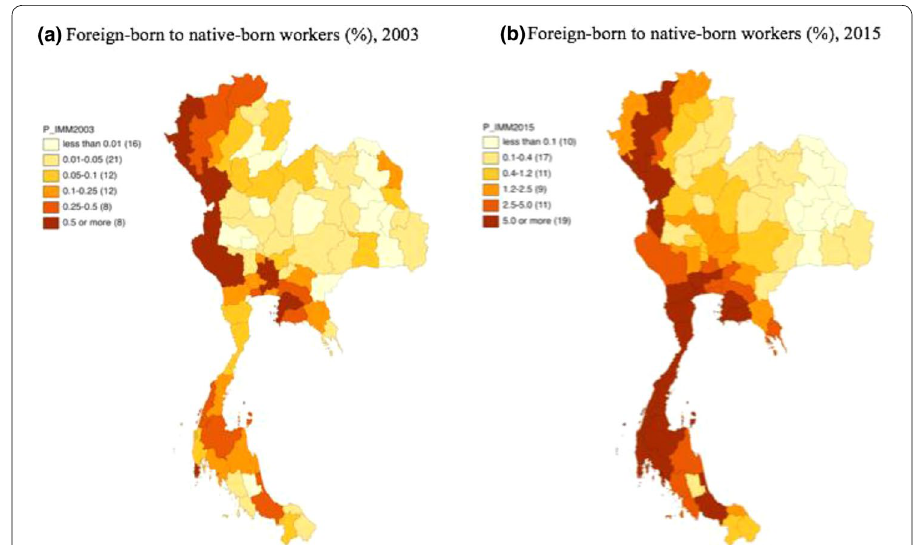
Fig. 3 Geographical distributions of foreign-born workers in Thailand. Source : created by author using data from Office of Foreign Worker Administration in 2003 and